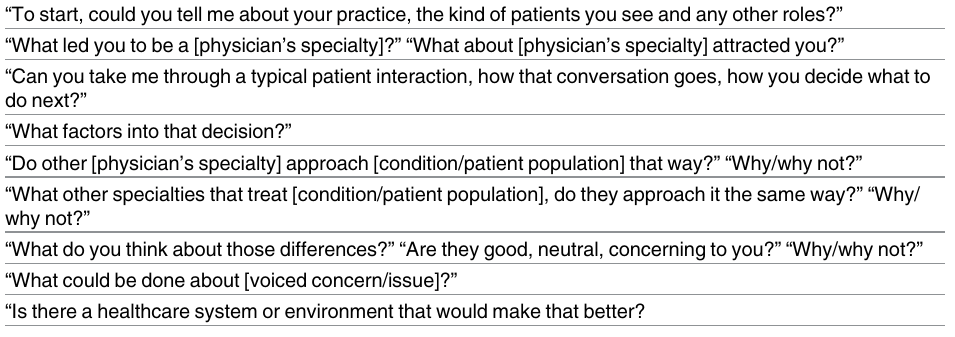
Table 2. Example interview